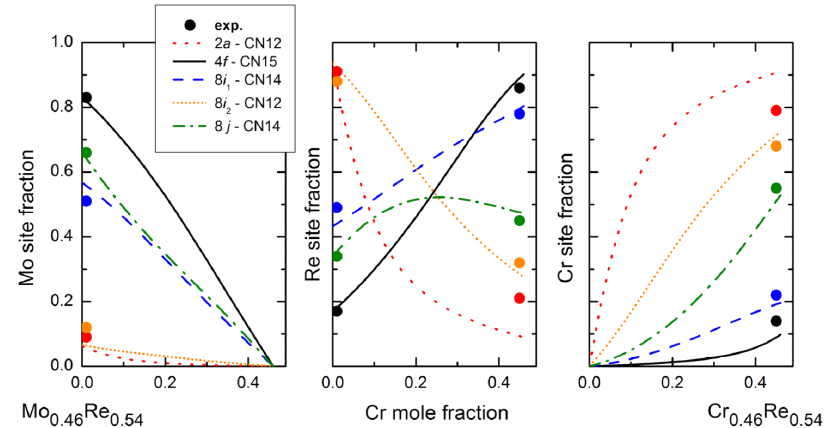
Figure 11. Calculated site occupancies at 1200 °C along the section Mo 0.46 Re 0.54 –Cr 0.46 Re 0.54 (blue line in Figure 10). The symbols correspond to the experimental occupancies at 1000 °C (Cr–Re) [20] and 1200 °C (Mo–Re)